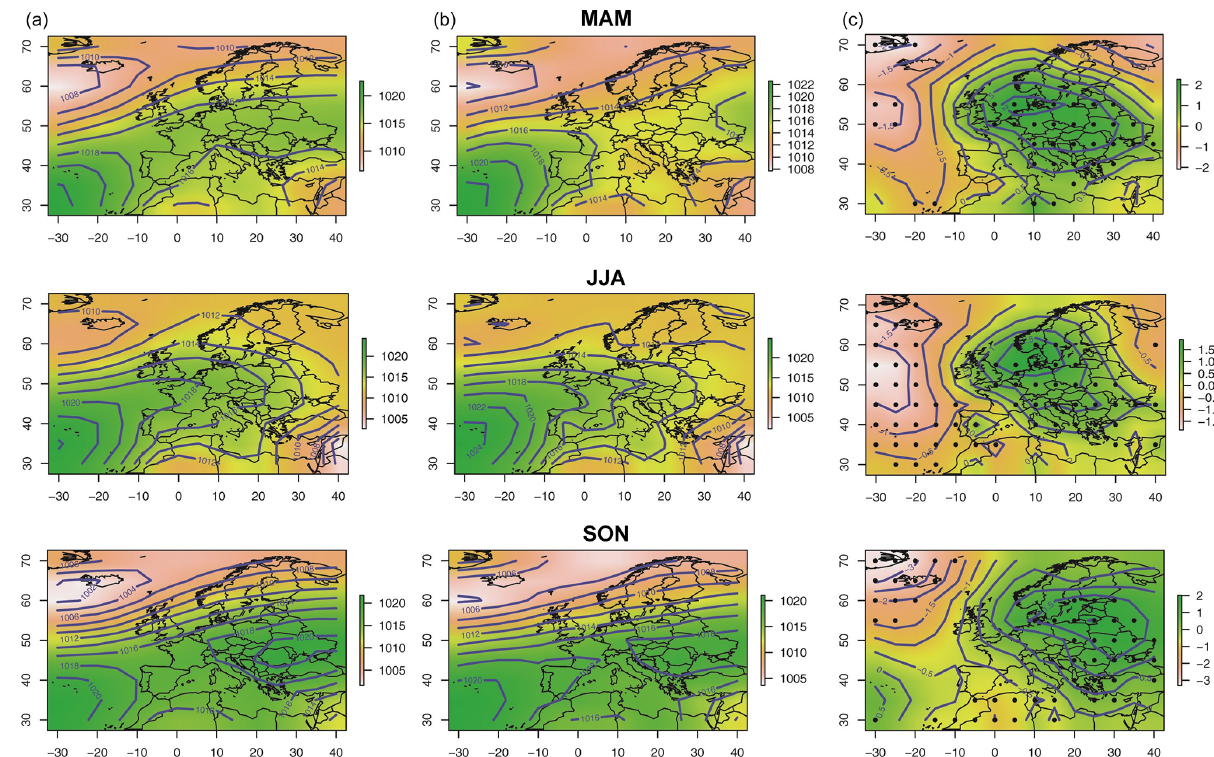
Figure 4. MAM, JJA and SON SLP of Czech extreme droughts in the Atlantic–European region: (a) SLP composite of extreme Czech droughts, (b) mean SLP field in the 1961–1990 period, (c) seasonal differences in SLP composite and mean SLP (dots identify grids in which pressure differences were statistically